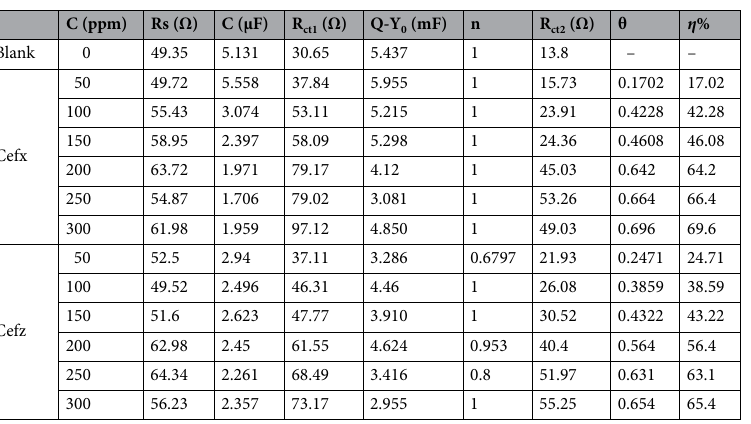
Table 3. Electrochemical parameters and the inhibition efficiencies of Al in 0.1 M NaOH solution based on EIS measurements in the absence and presence of different concentrations of Cefx and Cefz drugs at 293 K.